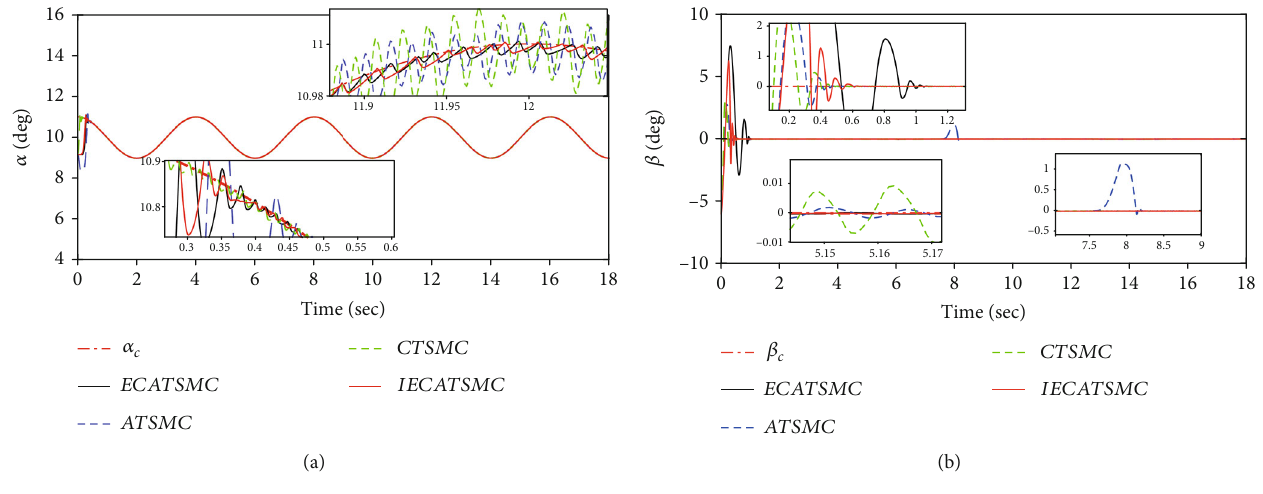
Figure 3: Tracking e ff ect of yaw and pitch